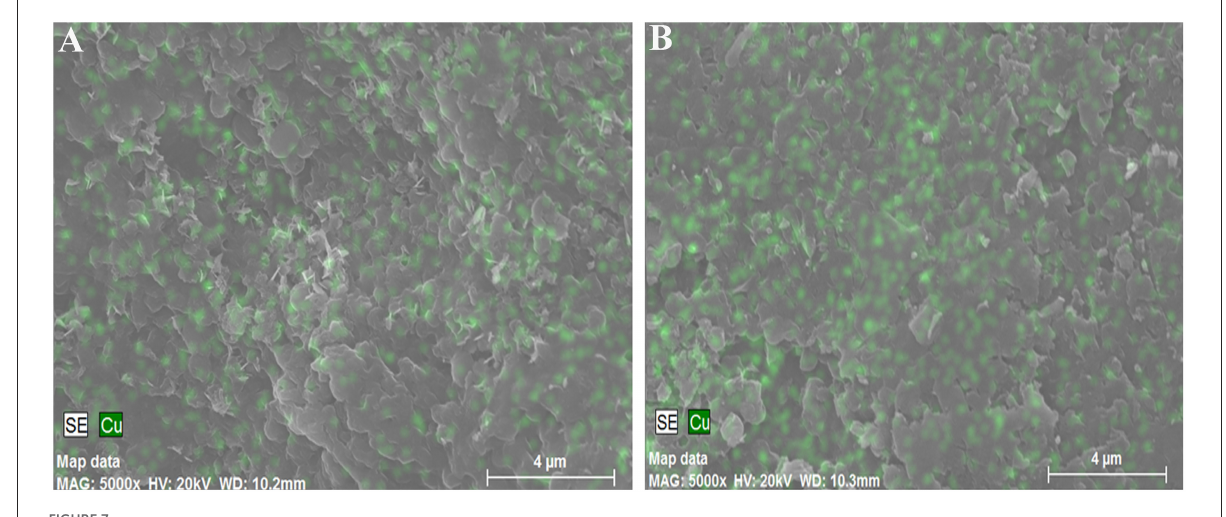
FIGURE7 Scanning electron micrograph of Spirulina strains AN8 (A) and RH44 (B)